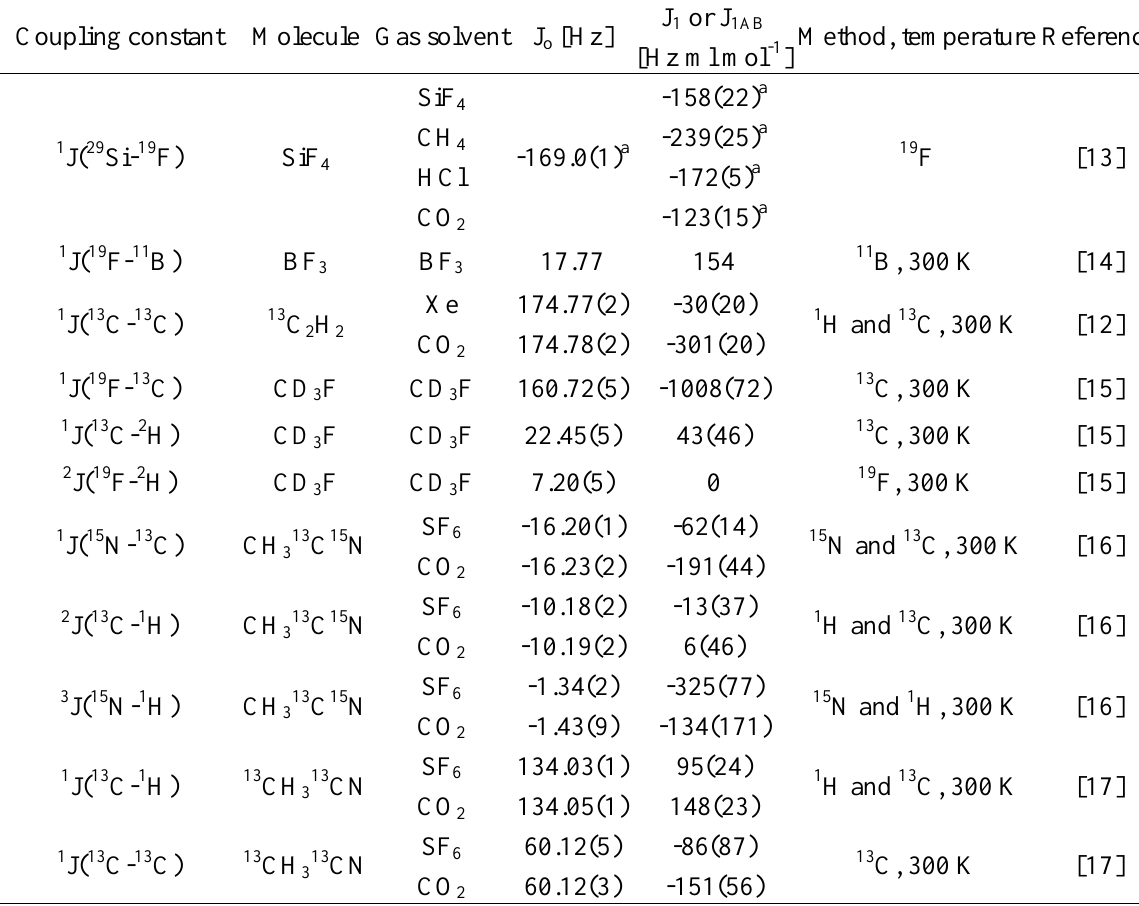
) and in binary mixtures ( n J 1